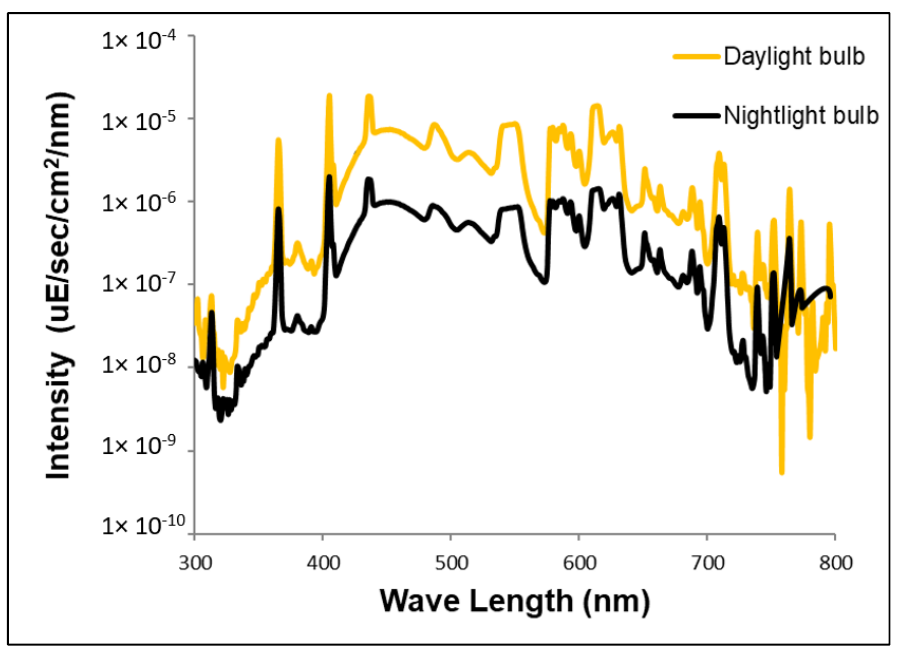
Figure 2. The spectrum and intensity of each light source that was used in the experiment for day and night-time illumi-